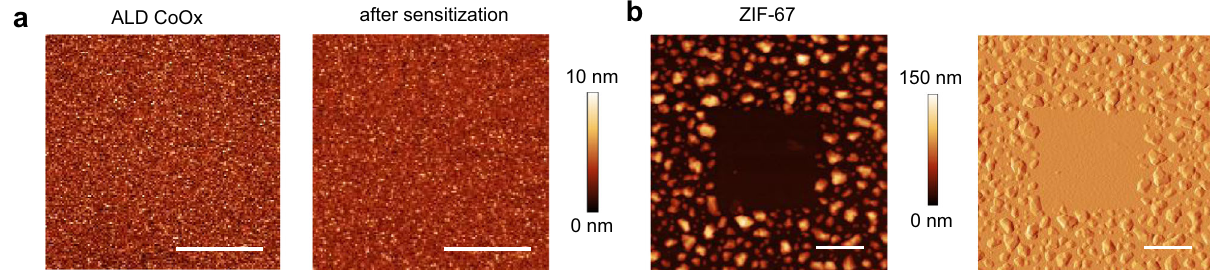
Fig. 5 Selective deposition of ZIF-67 from CoO x . a AFM images of an ALD CoO x fi lm before and after sensitization with 2mIm at 50 °C for 2 h. b AFM height (left) and amplitude error (right) images of a ZIF-free area on a ZIF-67 fi lm, prepared by e-beam irradiation (2 kV, 20 mC cm − 2 ) of a sensitized CoO x sample in a 2 µ m × 2 µ m square, followed by vapor treatment with 2mIm at 120 °C for 2 h. Scale bars are 1 µ